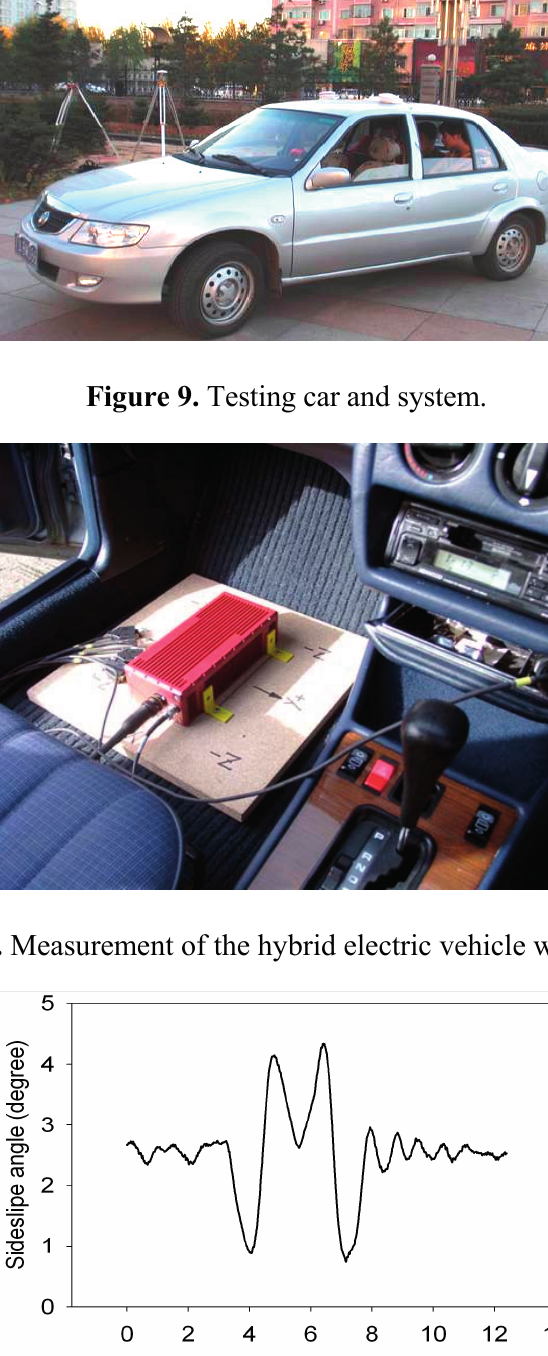
Figure 11. Sideslip angle